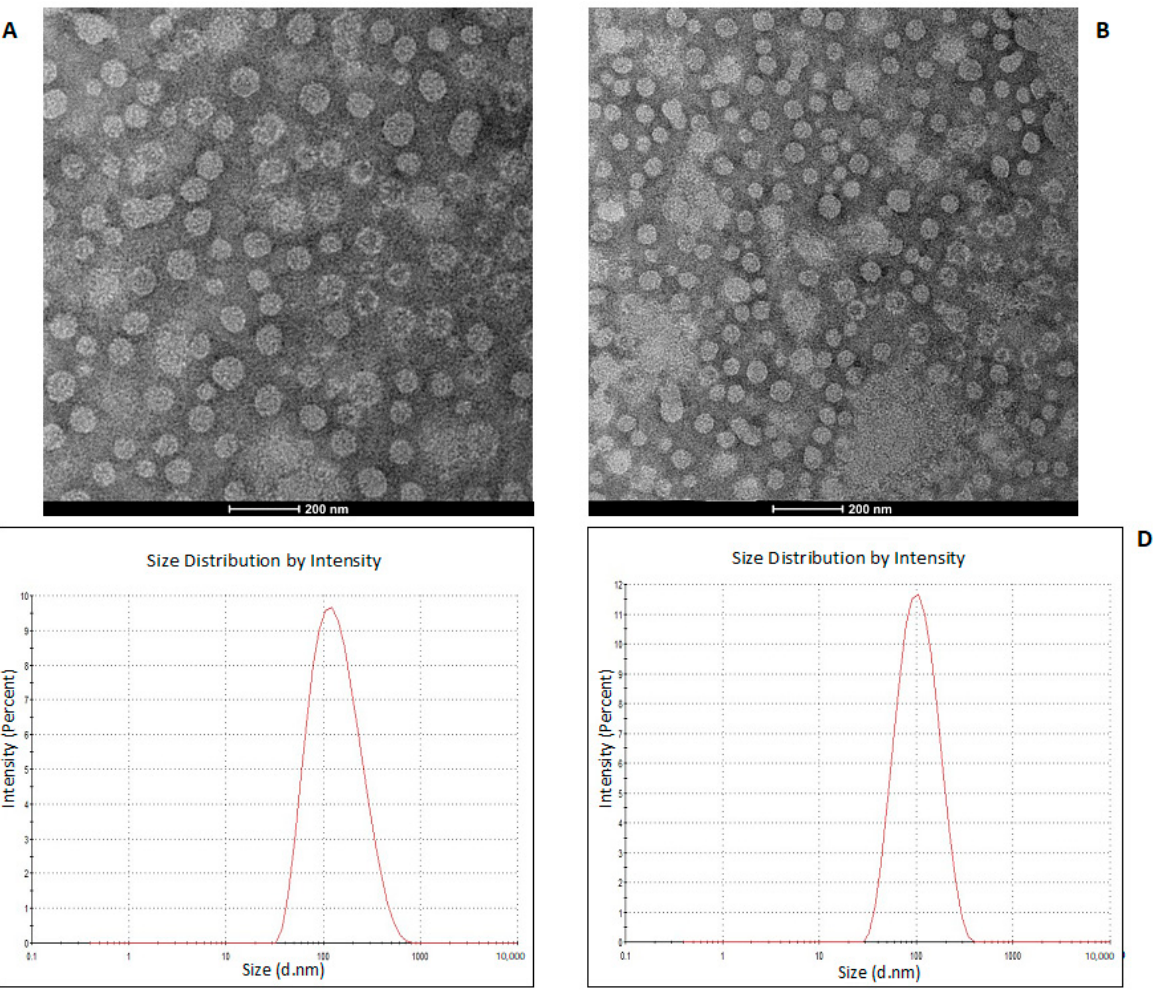
Figure 1. TEM of OMVs purified from K. pneumoniae -pGR ( A ) and K. pneumoniae -PRM ( B ) (scale bar = 200 nm). DLS intensity-weighed distribution of OMVs derived from K. pneumoniae -pGR ( C ) and K. pneumoniae -PRM ( D